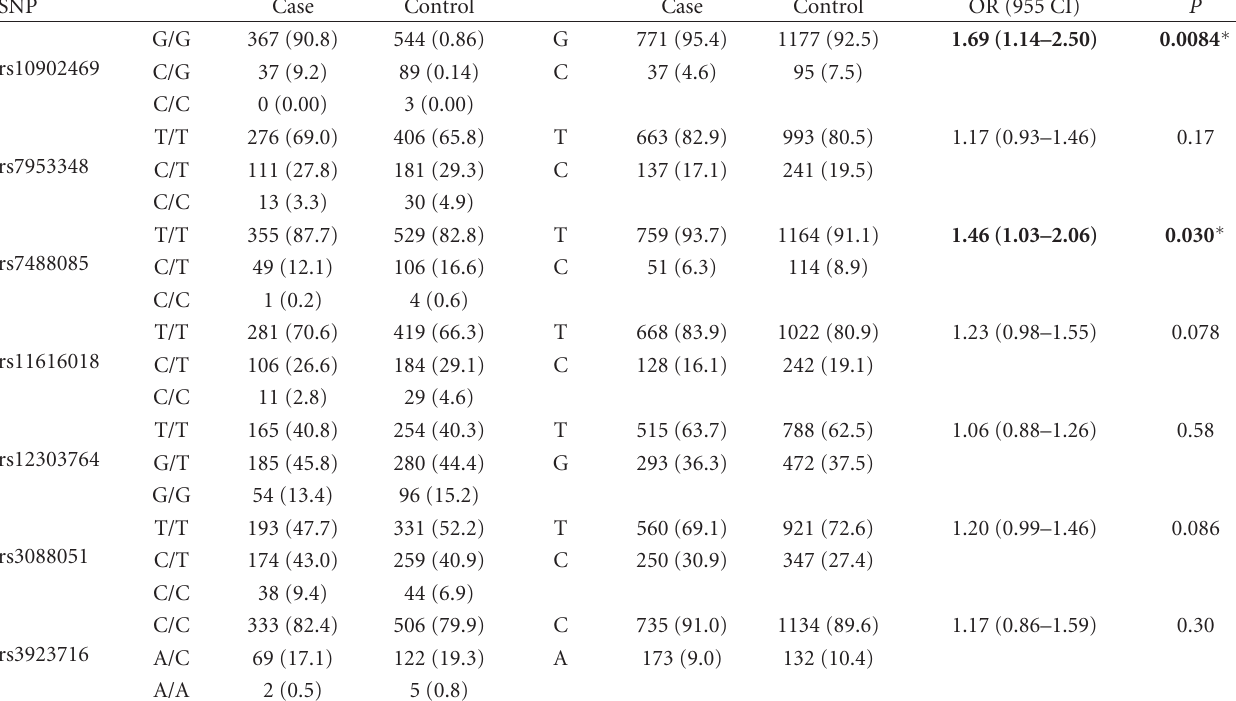
Table 2: Genotype and allele counts (and frequencies) in CD patients and in controls.